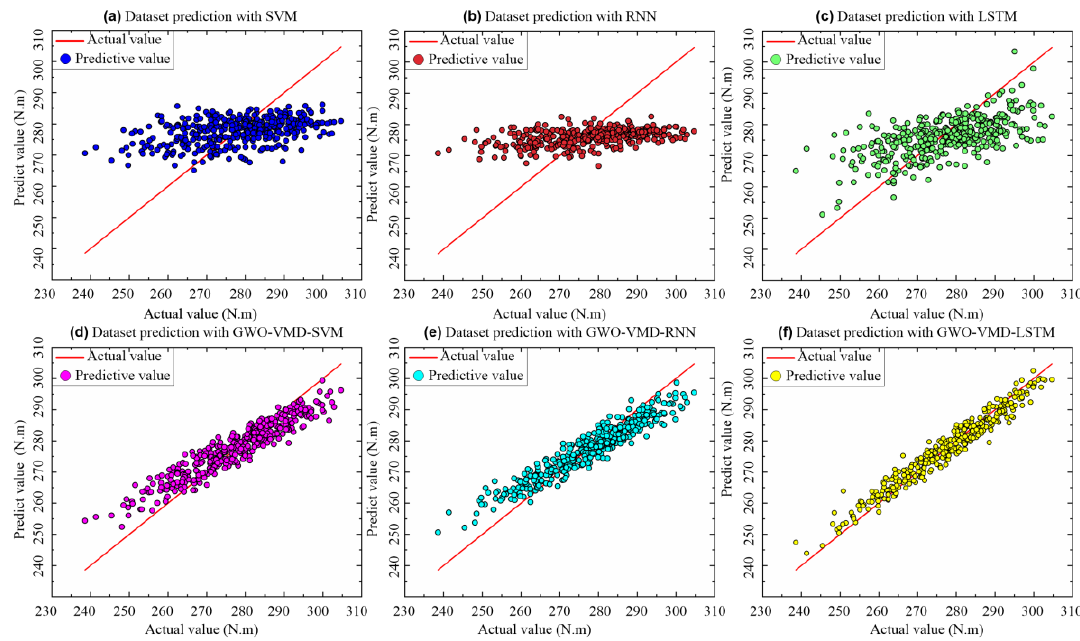
Figure 10. Fitting results of true and predicted values of different models.